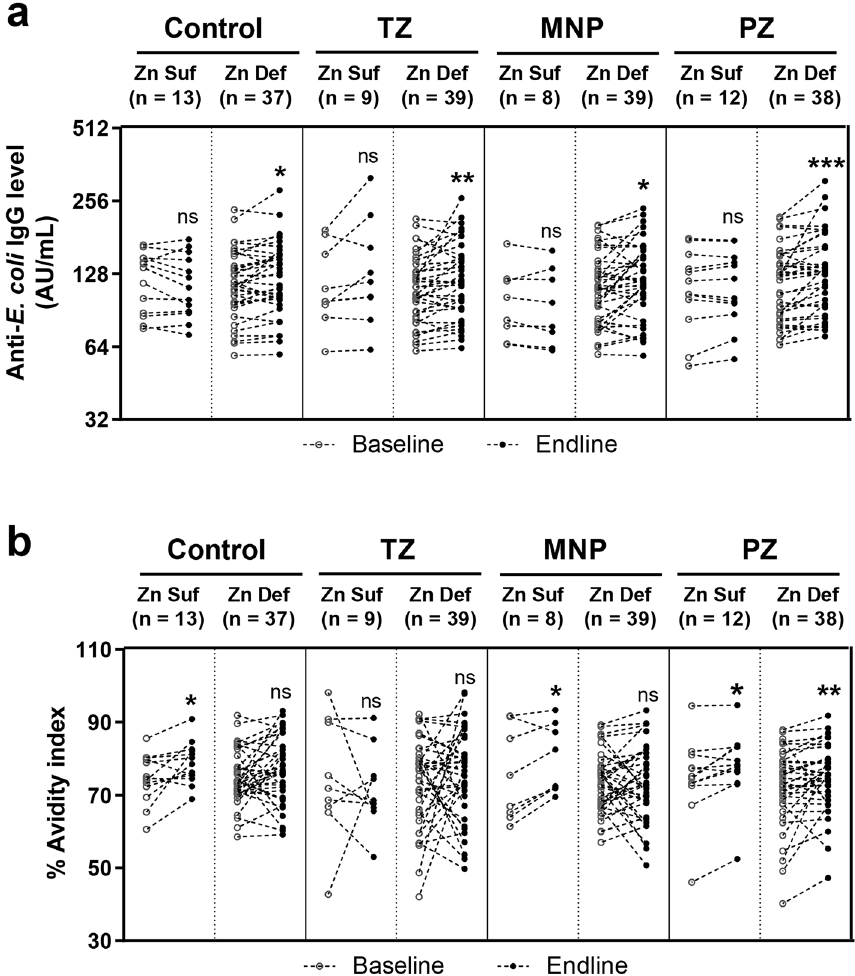
Figure 3. The plasma IgG level and avidity index of the four intervention groups divided by the baseline zinc status. For each group, the ( a ) plasma IgG level and ( b ) avidity index were divided into zinc-sufficient and zinc-deficient sub-groups ( C control; TZ therapeutic zinc with diarrhoea; MNP zinc-containing micronutrient powder; PZ preventive zinc). Children who had baseline plasma zinc lower than 65 μg/dL were categorised in the zinc-deficient sub-group. The sample sizes are indicated above each graph. Each dot represents an individual sample. Zn Suf zinc sufficient group; Zn Def zinc deficient group. The P-values indicate significant differences between baseline and endline of each intervention group determined by the Wilcoxon matched-pairs signed rank test. *P < 0.05; **P < 0.01; ***P < 0.001; ns